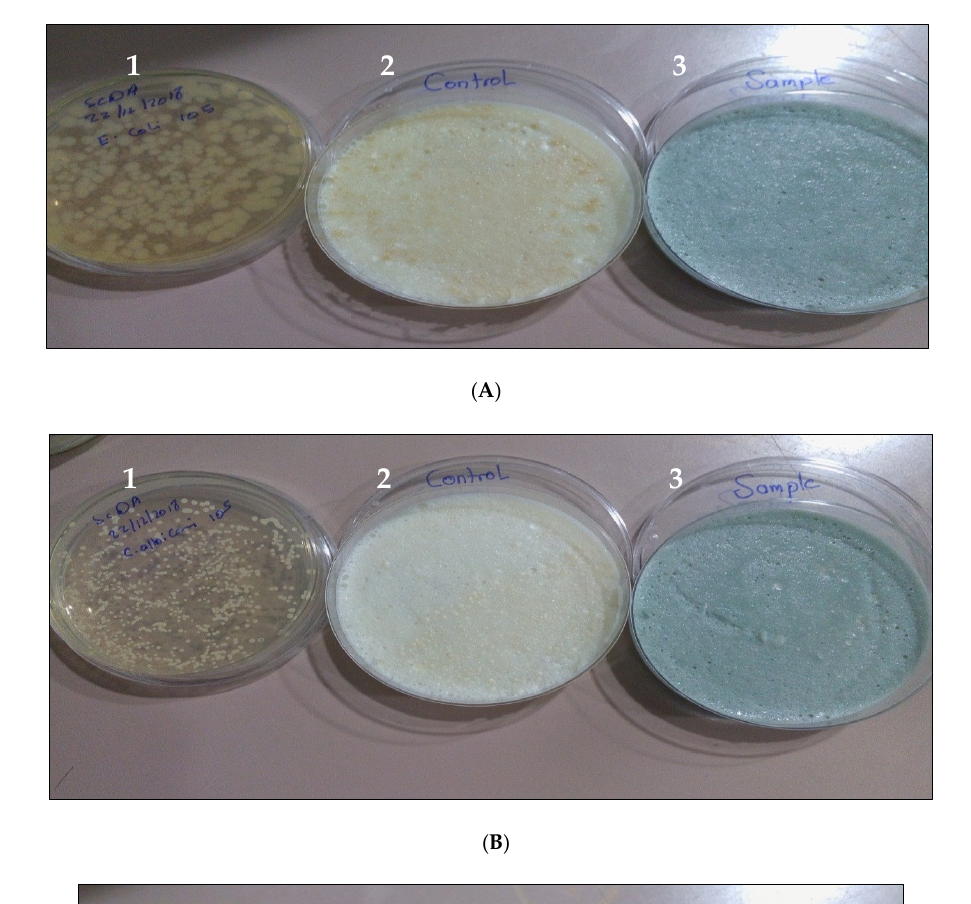
9 of 16 Figure 2. Viscosity of the F2 formula and fucidinTM at zero months and three months at 25 °C and accelerated conditions (40 ± 2 °C/75% ± 5% RH). 3.6. Determination of the MICs for Cream Formulations, Their Active Substances, and FRSA Sample